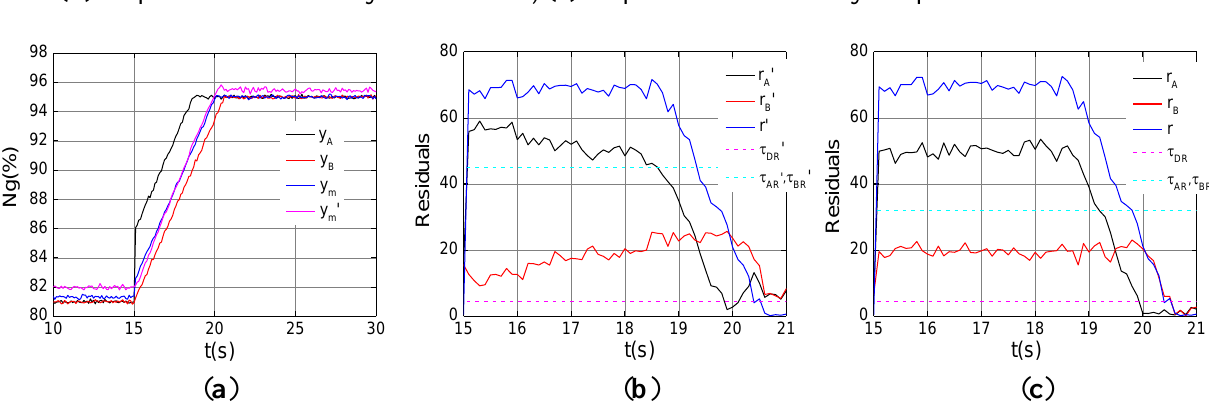
Figure 12. Channel A with the step fault in the dynamic operation. ( a ) Triplex channel outputs; ( b ) Step fault indication by SPSO-SVR; ( c ) Step fault indication by simplified